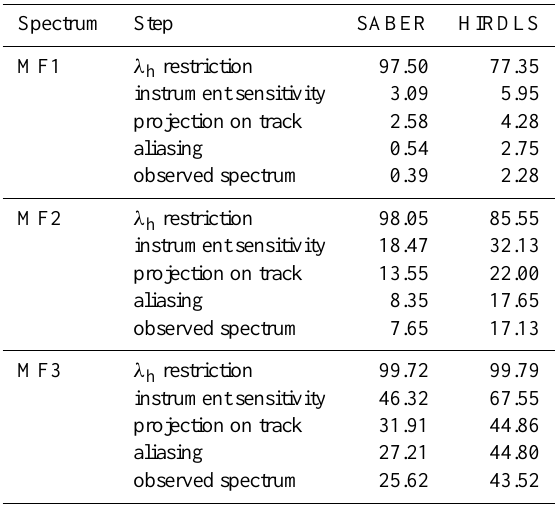
Table 1. Percentages of remaining GWMF at main steps during the observational